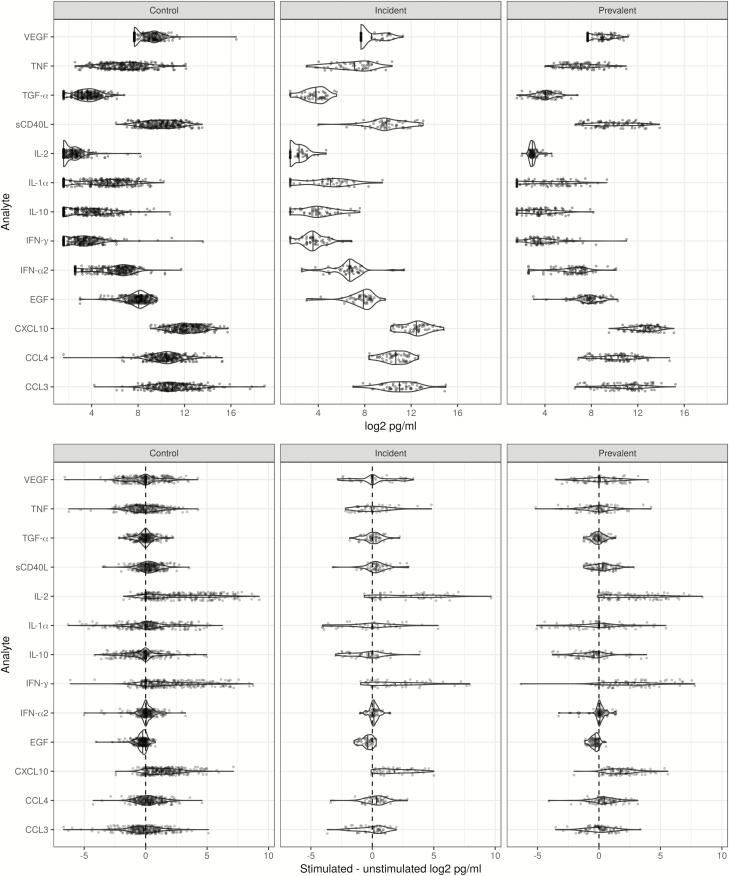
Raw data dot plots for unstimulated (top row) and antigen-stimulated, background-adjusted (bottom row) analytes in control, incident tuberculosis, and prevalent tuberculosis comparison groups. Distributions were estimated by violin plots with the median value indicated by a solid vertical line. All values are plotted on a log2 scale, and a vertical dashed line is plotted at a difference of 0. Abbreviations: CCL, chemokine (C-C motif) ligand; CXCL10, C-X-C motif chemokine 10; EGF, epidermal growth factor; IFN, interferon; IL, interleukin; sCD40L, soluble CD40 ligand; TGF-α, transforming growth factor-α; TNF, tumor necrosis factor; VEGF, vascular endothelial growth factor.